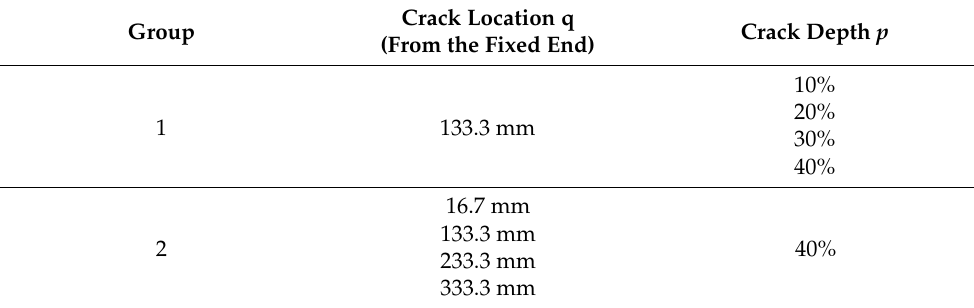
Figure 14. Tested cantilever beam.